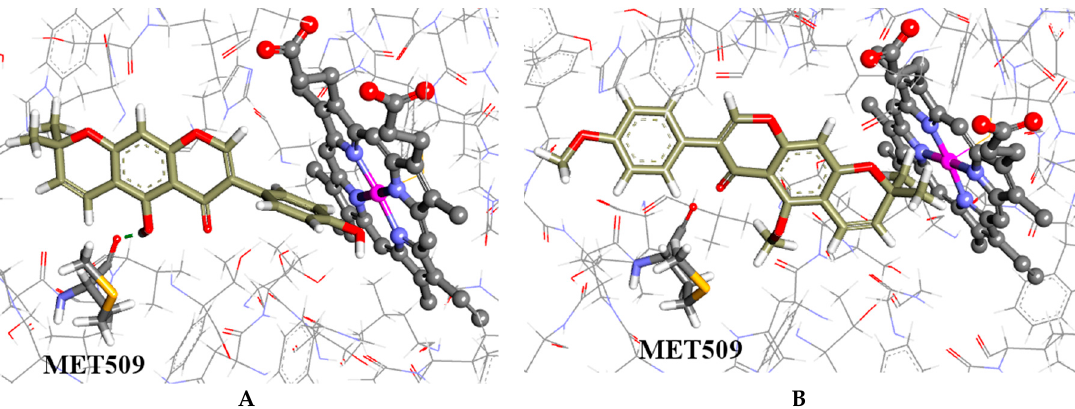
Figure 4. ( A ) the docked configuration of alpinumisoflavone ( 3 ) in the binding site of CYP51; and ( B ) the docked configuration of O , O -dimethylalpinumisoflavone ( 4 ) in the binding site. Hydrogen bonds are shown as green dotted lines.